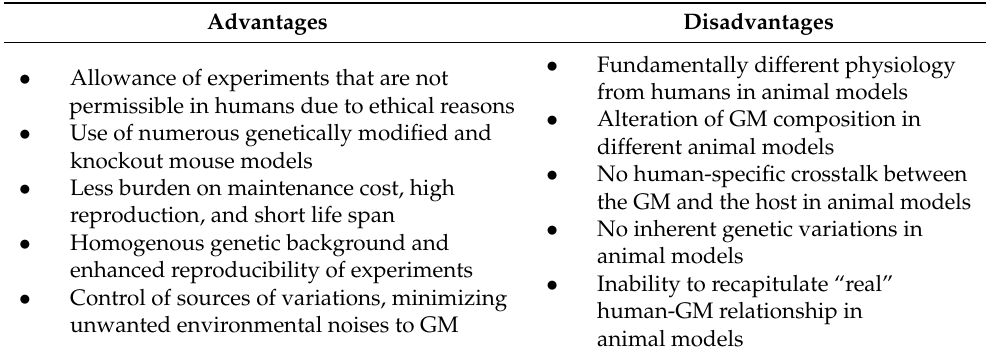
Table 1. The advantages and disadvantages of animal models in studying the effects of gut microbiota on Alzheimer’s disease